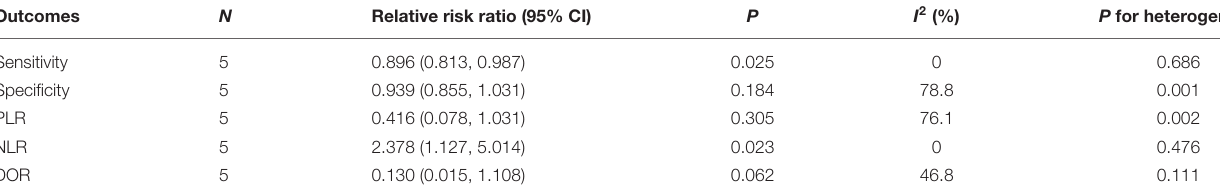
TABLE 3 | Relative risk ratios between WBMRI and PET/CT for sensitivity, specificity, PLR, NLR, and DOR. Outcomes